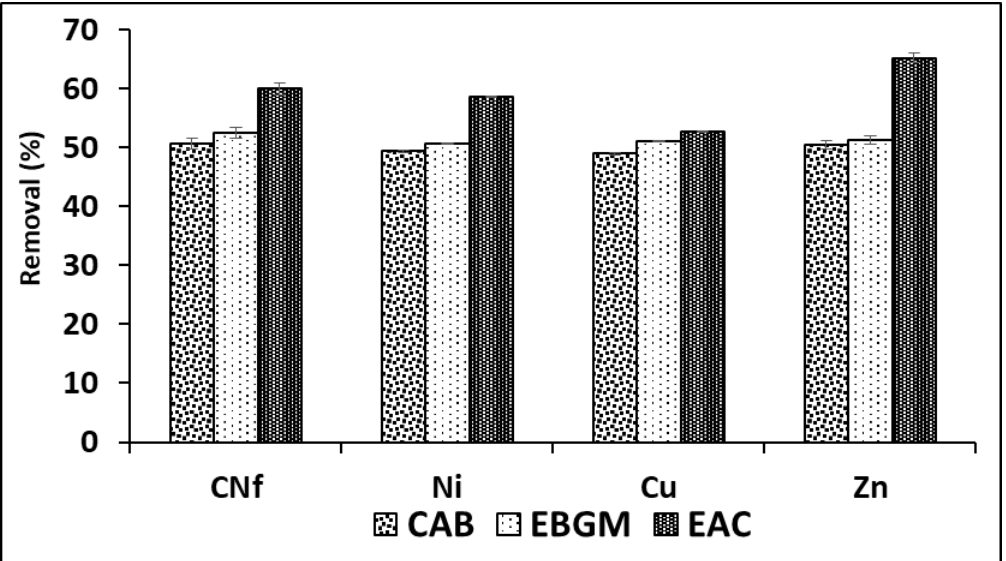
Figure 1. Percentages of removal of free cyanide and heavy metals onto three different bioadsorbents (CAB, EBGM and EAC) using a ratio 1:1 ( v / v ) between bioadsorbent/raw wastewater. Table 2. Statistical analysis (ANOVA and t -test) for comparing the removal percentages obtained, for all pollutants, using the three bioadsorbents tested (CAB, EBGM and EAC).